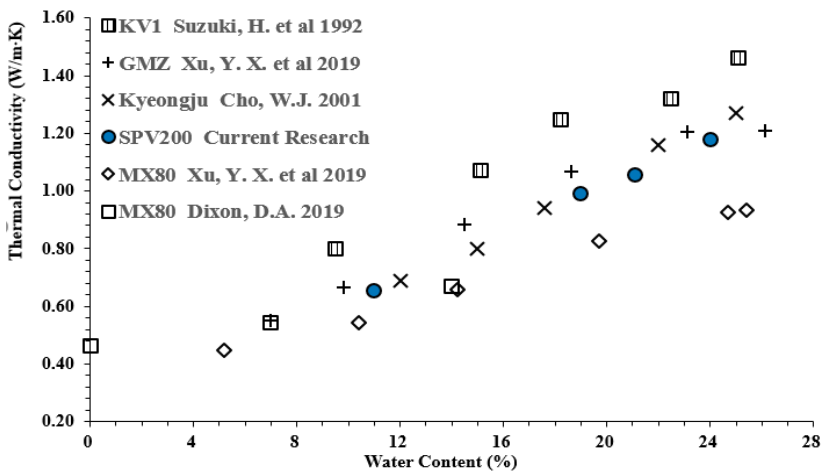
Figure 12. Thermal conductivity vs. water content relationship for various compacted bentonites [10,